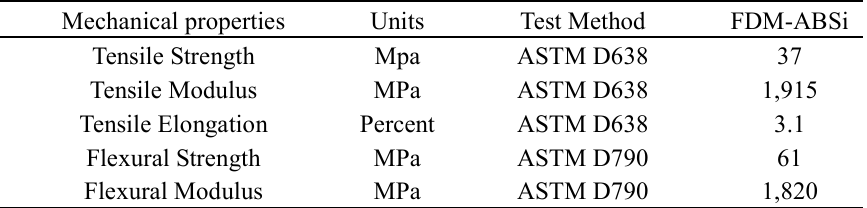
Fig.2 Model tested FDM Table 1. Material Properties of FDM–